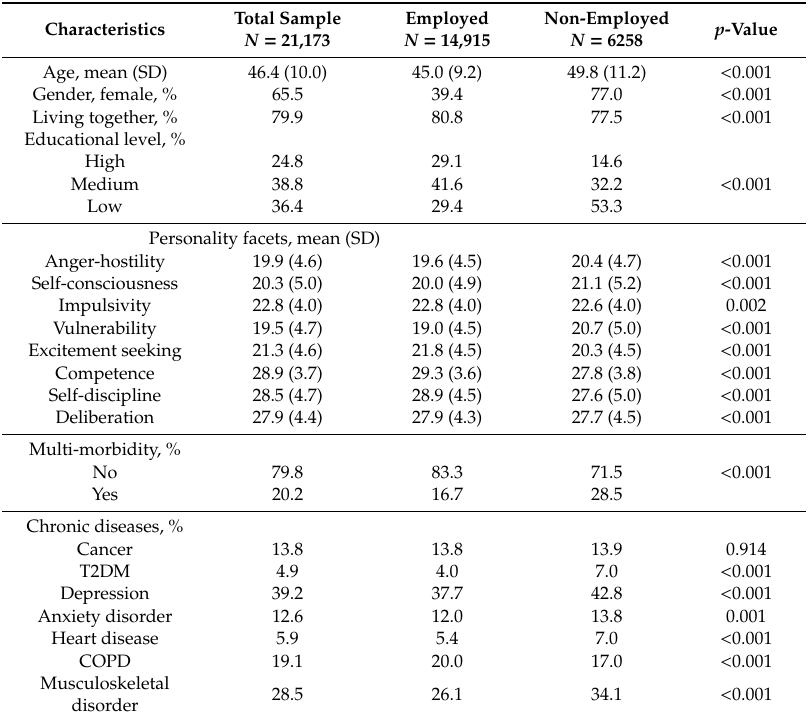
Table 2. Baseline